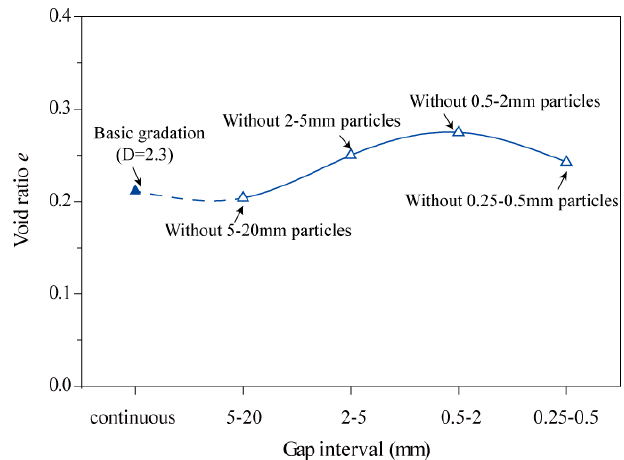
Figure 3. Void ratios of the soil-rock mixture (SRM) with basic gradation D = 2.3 at different gap intervals.